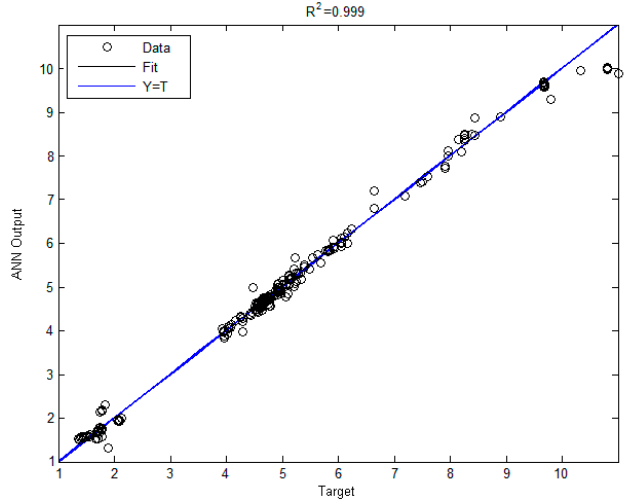
Figure 5. Dispersion of ANN-PSO outputs compared to Computational Fluid Dynamics (CFD) outputs.